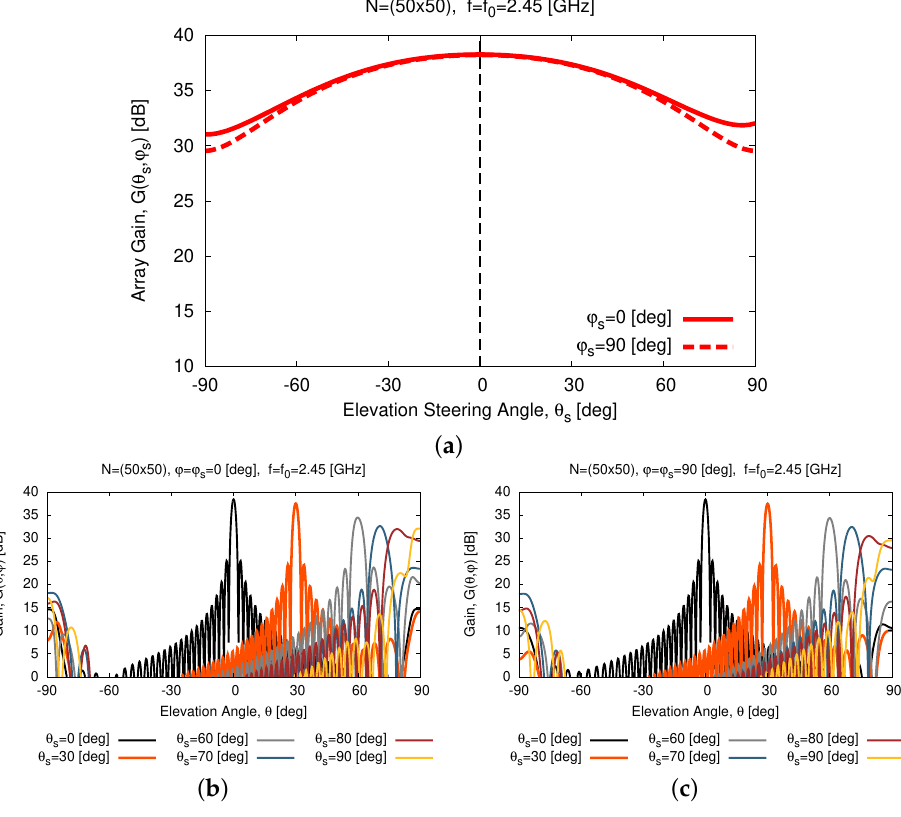
Figure 12. Numerical Assessment ( [ f min , f max ] = [ 2.3, 2.6 ] [GHz], f = f 0 = 2.45 [GHz]— N = ( 50 × 50 ) ) —Plot of ( a ) the array gain in the angular steering direction, ( θ s , ϕ s ), when scanning the beam towards θ s ∈ [ − 90, 90 ] [deg] and ϕ s = 0 [deg] or ϕ s = 90 [deg] along with the corresponding far-field patterns at ( b ) ϕ s = 0 [deg] and ( c ) ϕ s = 90 [deg].